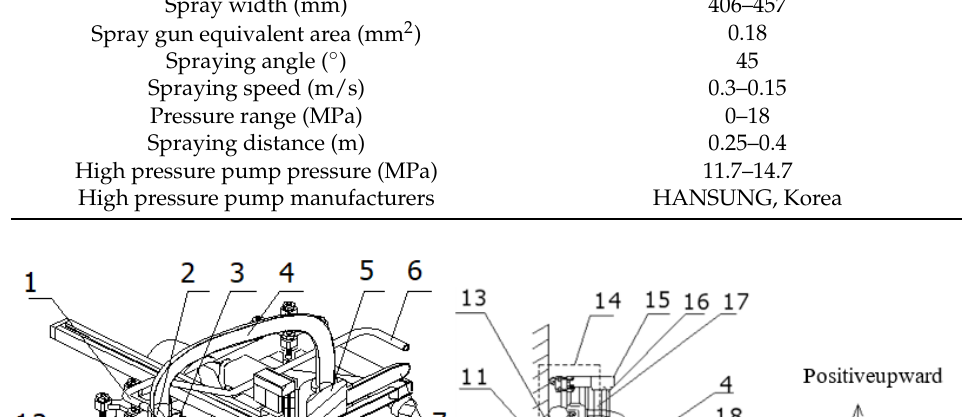
Figure 4. The current situation of manual work for painting the inner and outer plates of ship docks of the ship dock: ( a ) Spray gun painting distance; ( b ) “Zigzag” painting trajectory. The basic parameters of the spray gun recommended by the paint manufacturer are shown in Table 1. Table 1. Spray gun and paint type and working parameters. Paint